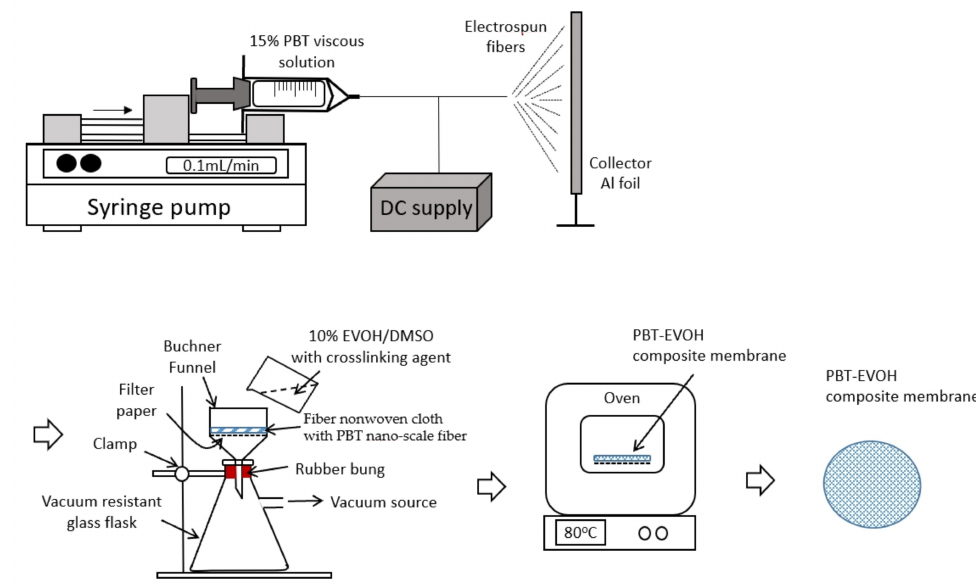
Figure 1. Schematic illustration of the preparation of polybutylene terephthalate–ethylene vinyl alcohol (PBT–EVOH) composite